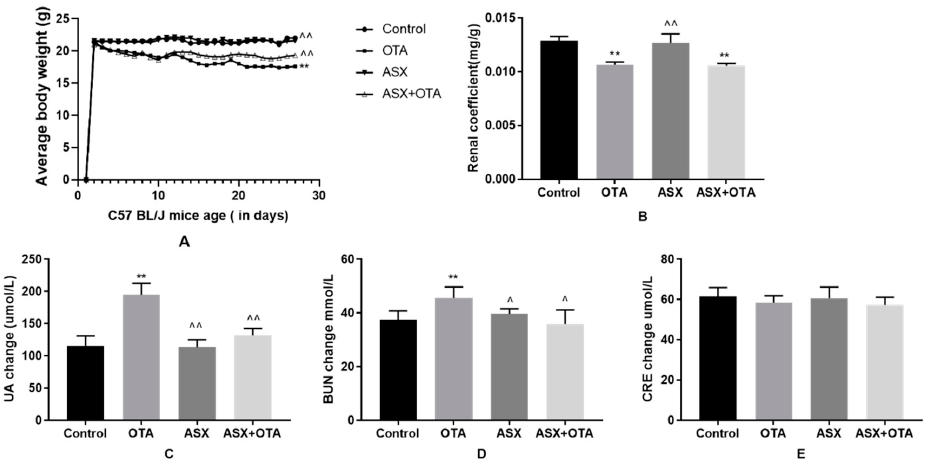
Figure 1. Assessment of mouse average body weight, organ coefficients and changes in serum biochemical indicators. ( A ) Average body weight change of C57BL/J from day 1 to day 27, ( B ) renal organ coefficients, ( C ) changes in uric acid (UA) levels, ( D ) changes in blood urea nitrogen (BUN) levels, and ( E ) changes in creatinine (CRE) levels in the different groups. Values represent the mean ± standard deviation (SD). n = 8 mice/group. ^ p < 0.05, ^^ p < 0.01 vs. the ochratoxin A (OTA) group; * p < 0.05, ** p < 0.01 vs. the control group.